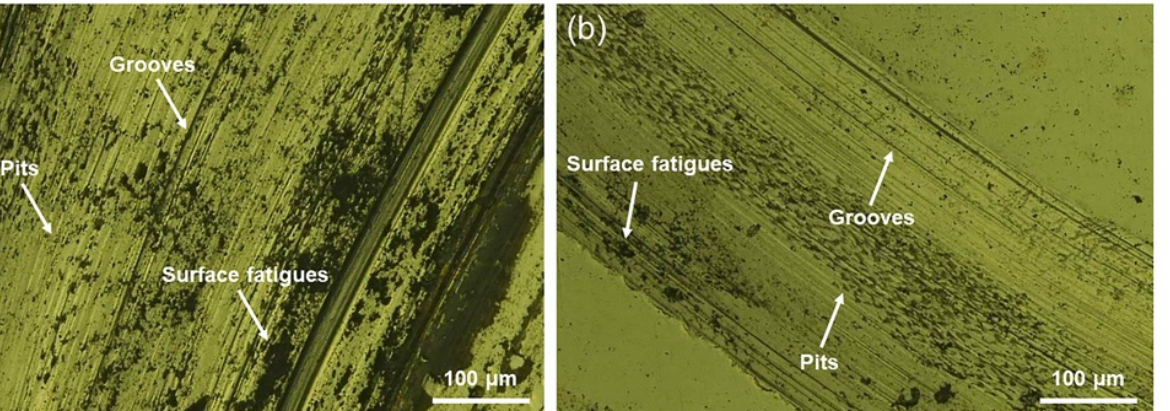
Figure 7. Metallurgical-microscopy images of the wear scars: ( a ) CAST and ( b ) SLM.